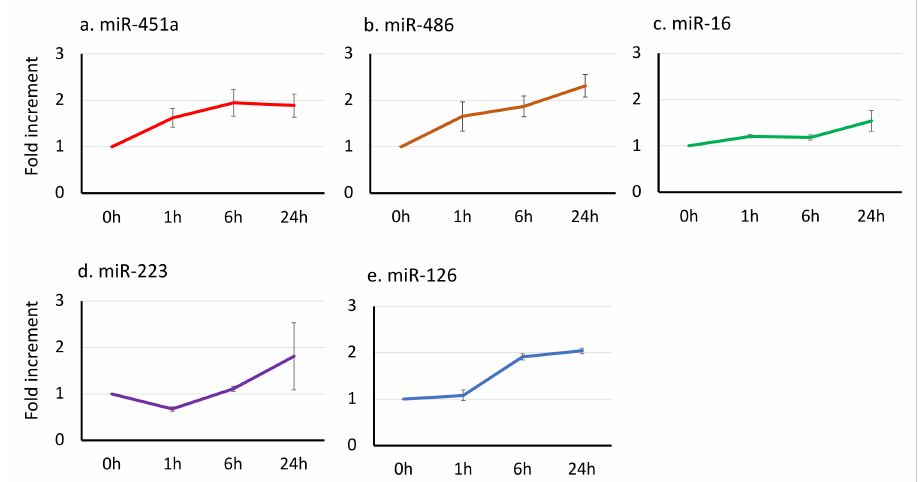
Figure 3. Relative increments of miRNAs before serum separation at 0, 1, 6, 24 h lag-time. miRNAs were assayed with the RT-qPCR method. Each value (average ± SEM, n = 8) shows fold increments of miRNAs after blood drawing at each time points, ( a ) miR-451a, ( b ) miR-486; ( c ) miR-16; ( d ) miR-223; ( e ) miR-126.